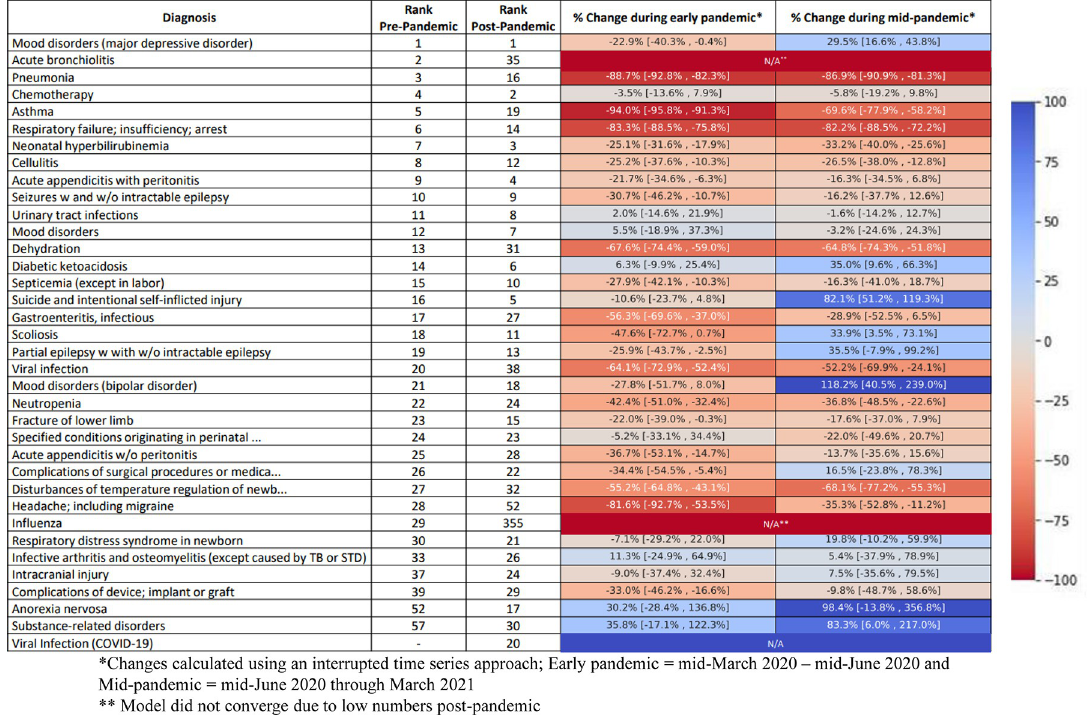
Fig 3. Pandemic changes in leading causes of hospitalization with heat